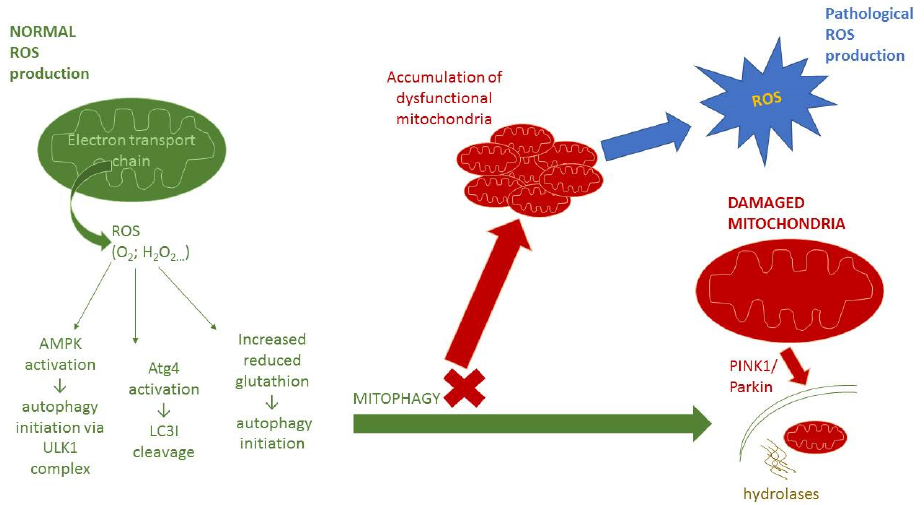
Figure 1. Mitophagy and mitochondrial function. Abbreviations: ROS—reactive oxygen species, O 2